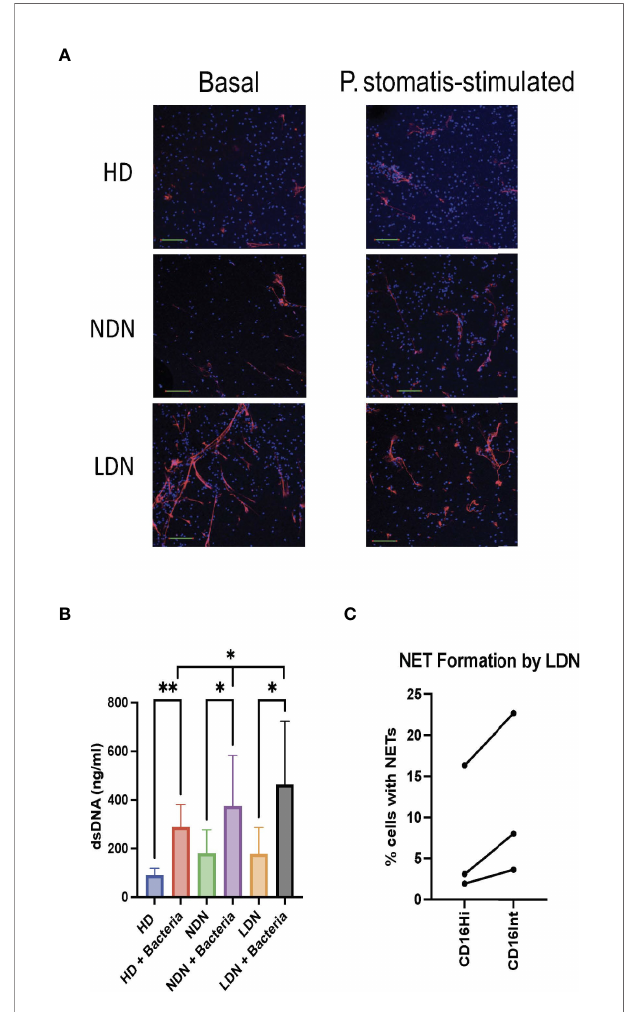
FIGURE 3 | Enhanced NET formation by COVID-19 LDN. Panel (A) shows merged confocal images of lactoferrin staining of NETs (Red) and DAPI staining of DNA (Blue), demonstrating NET formation, in the absence (Basal) or presence of CFSE-labelled P. stomatis , in HD NDN, COVID NDN, and COVID LDN, representative of 4 experiments. Images shown are stacks of the entire collection of acquired z-planes at 20x magni fi cation, scale bar=100 mm. Individual images are shown in Supplemental Figures 1 and 2 . Panel (B) shows release of dsDNA into supernatant from basal or P. stomatis stimulated HD NDN, COVID NDN, and COVID LDN. NET formation by COVID LDN was signi fi cantly greater following bacterial stimulation, compared to COVID NDN and HD NDN, n=12-15. *p < 0.05, **p < 0.01. Panel (C) shows the results of 3 separate experiments comparing the percent of CD16 Hi LDN and CD16 Int LDN spontaneously forming NETs, visualized by confocal